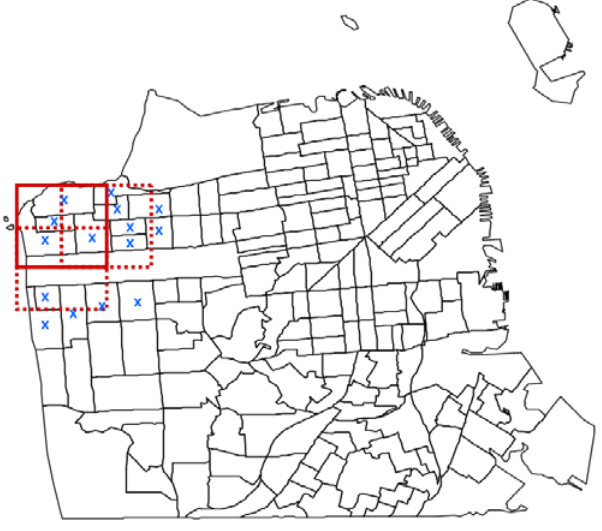
Figure 2. An illustration of partitioning the map of San Francisco using the overlapping square grid approach. Three overlapping squares, representing three spatial scanning windows in the detection method, are overlaid upon the northwest quadrant of San Francisco. The map is partitioned by census tracts. A single square size and only a few census tract centroids (blue ‘x’ symbols) are represented in this example for illustrative purposes.